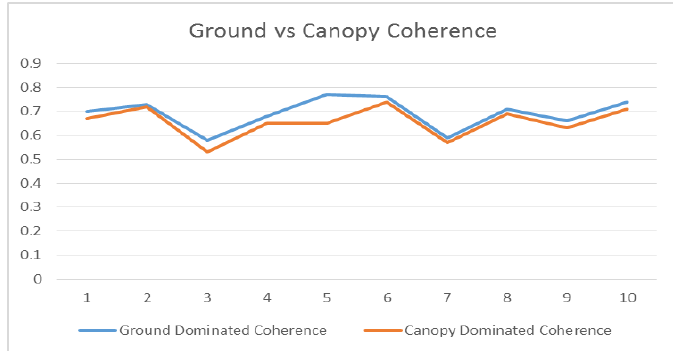
Figure 5. Ground vs Canopy dominated coherence